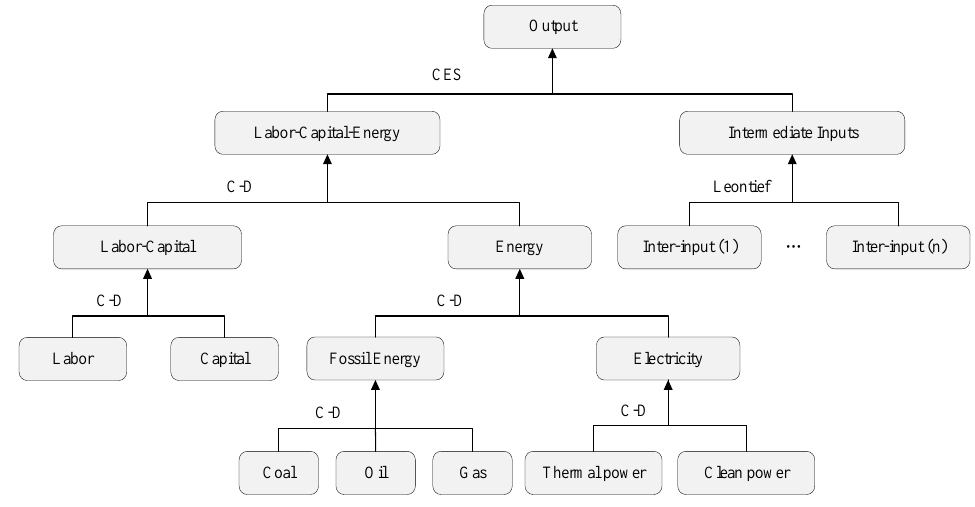
Figure 2. The framework of production block.